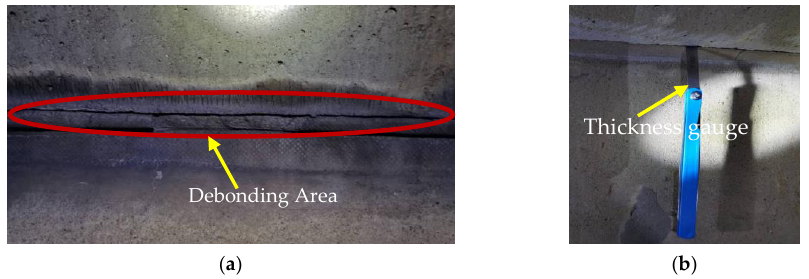
Figure 3. ( a ) Debonding area. ( b ) Measurement by thickness gauge.